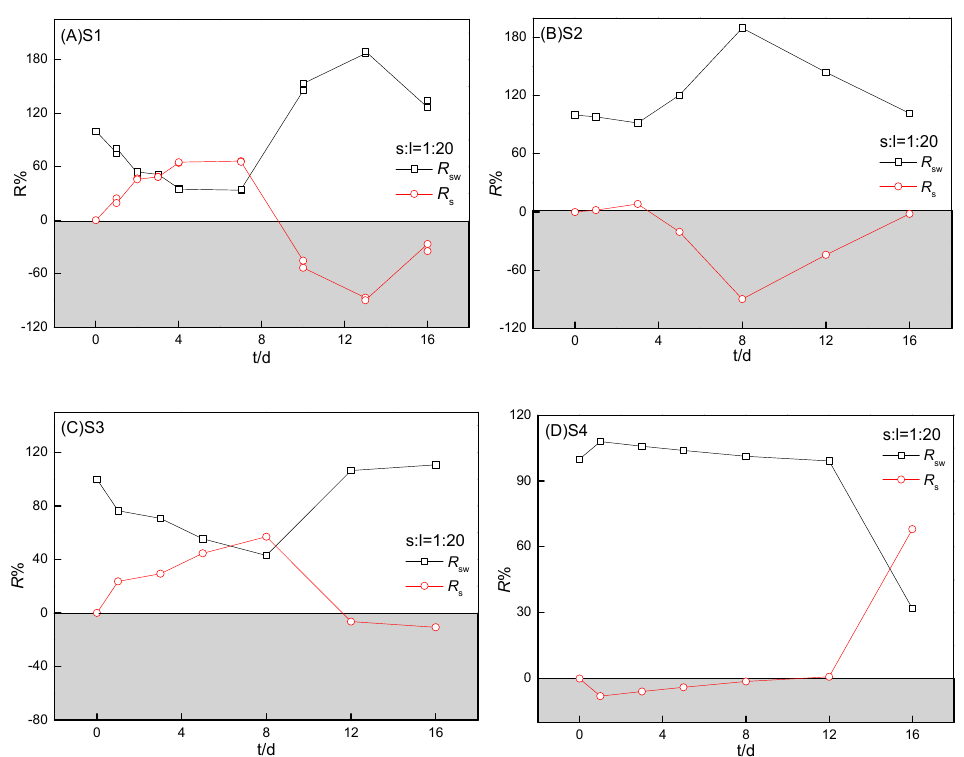
Figure 6. Relative contribution of internal sediment loading (S1) and external pollution (sample water) to aqueous ammonium during incubation at different sediment-to-water ratios. The sediment-to- water ratios for ( A ), ( B ), ( C ), and ( D ) were 1:20, 1:10, 1:5, and 1:1, respectively. R sw (%) is the relative contribution of the sample water to ammonium and 𝑅 (cid:3046) (%) is the relative contribution of sediment to ammonium in the sample water–sediment system.